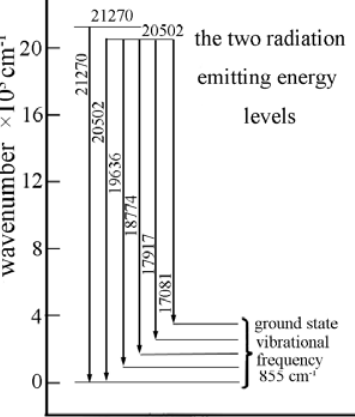
Figure 9. Inter- and intramolecular nonradiative energy transfer in solid UO 22+ - Datura samples